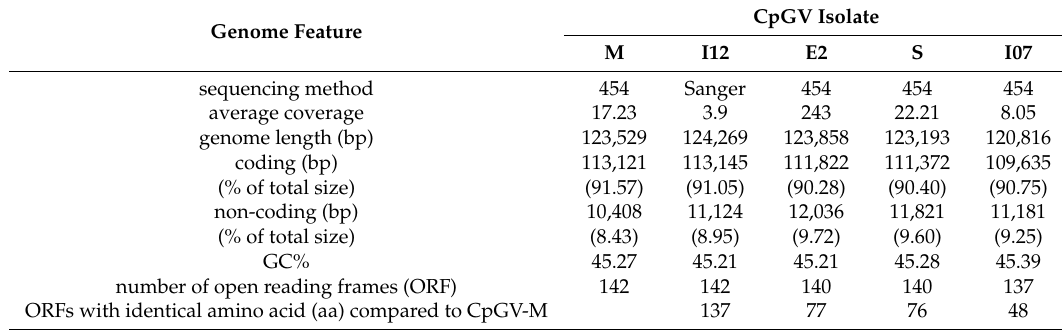
Table 1. General Cydia pomonella granulovirus (CpGV) genome